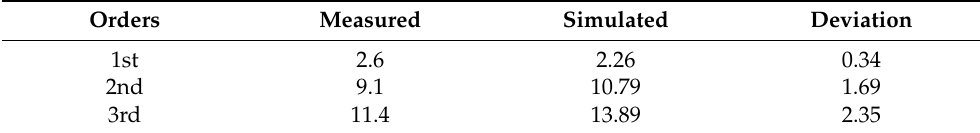
Table 2. Comparison of resonant frequencies from simulation and experiment (Unit: Hz).